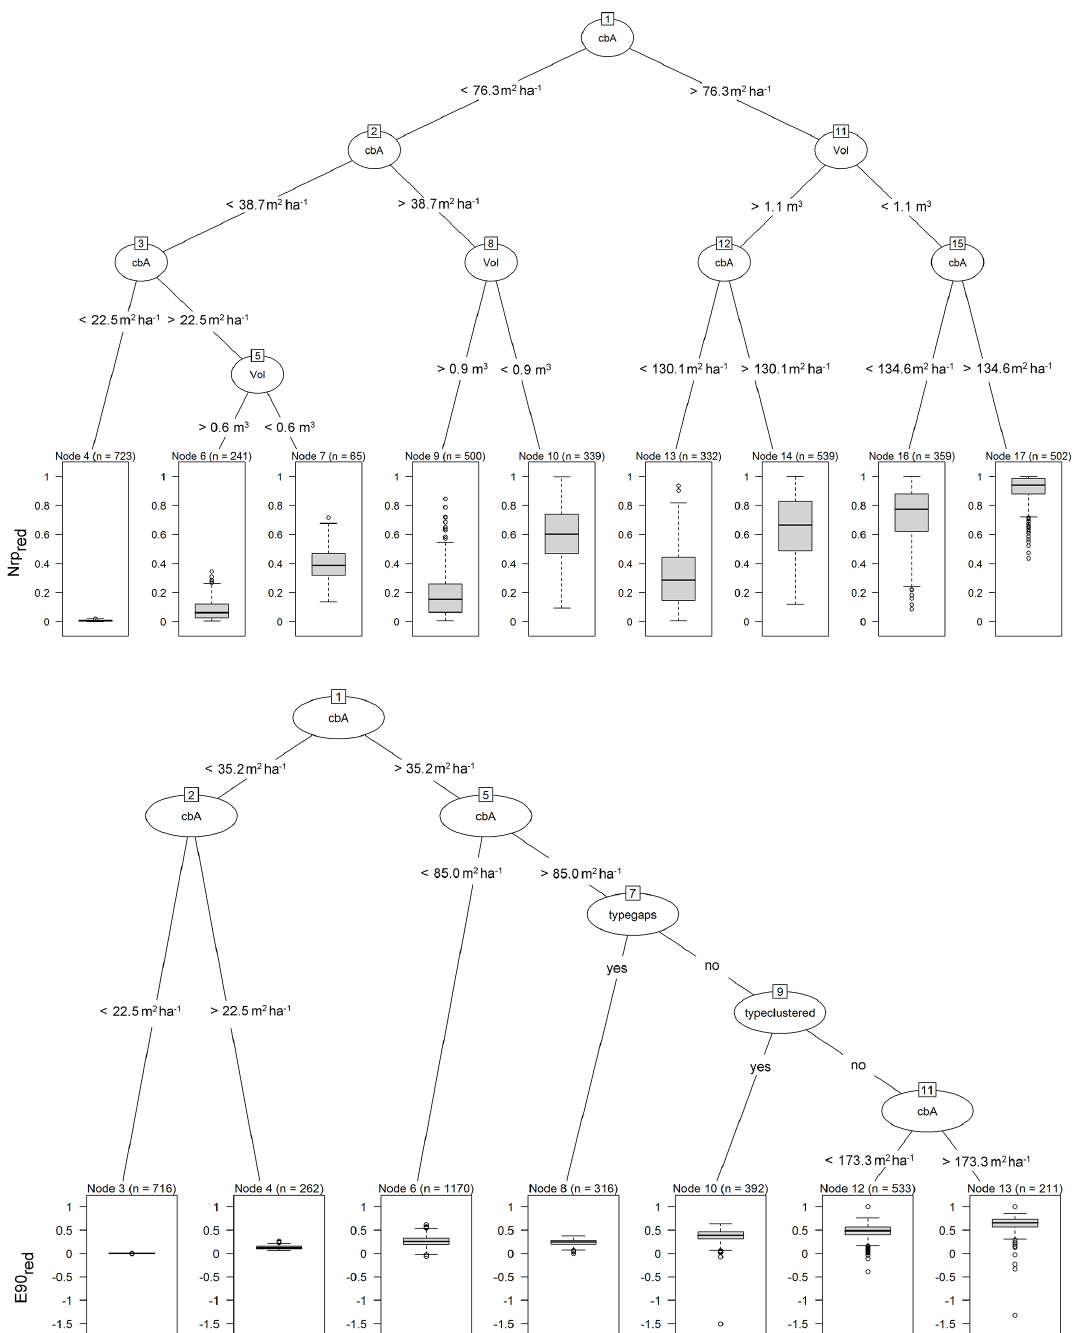
Figure 8. Regression tree models were used to predict the reduction in rockfall occurrence frequency (RT Freq ; above) and the reduction in rockfall intensity (RT Int ; below) by forests. The models were fitted with a training set representing 75% of the entire data set ( n = 3600) and by applying a 10-fold cross-validation three times. The nodes represent the splitting variables followed by the applied threshold value. cbA is cumulative basal area [m 2 ha − 1 ], Vol is volume [m 3 ], typegaps is gappy tree distribution [yes, no], typeclustered is a clustered tree distribution [yes,